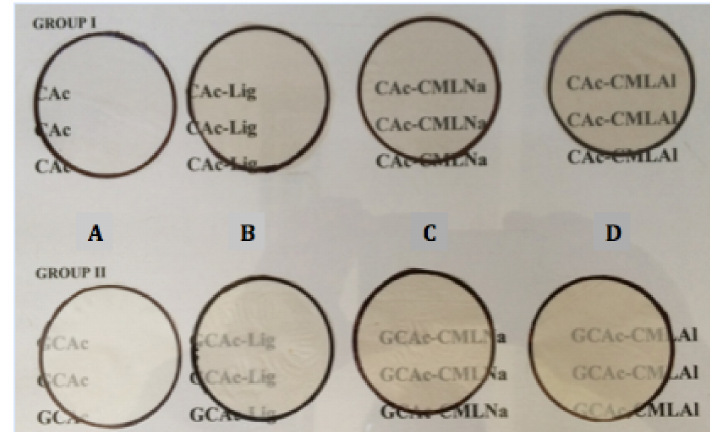
Figure 1. Eight membranes of cellulose acetate (CA) produced. The letters A, B, C and D refer to the membranes of groups I and II described in this figure.